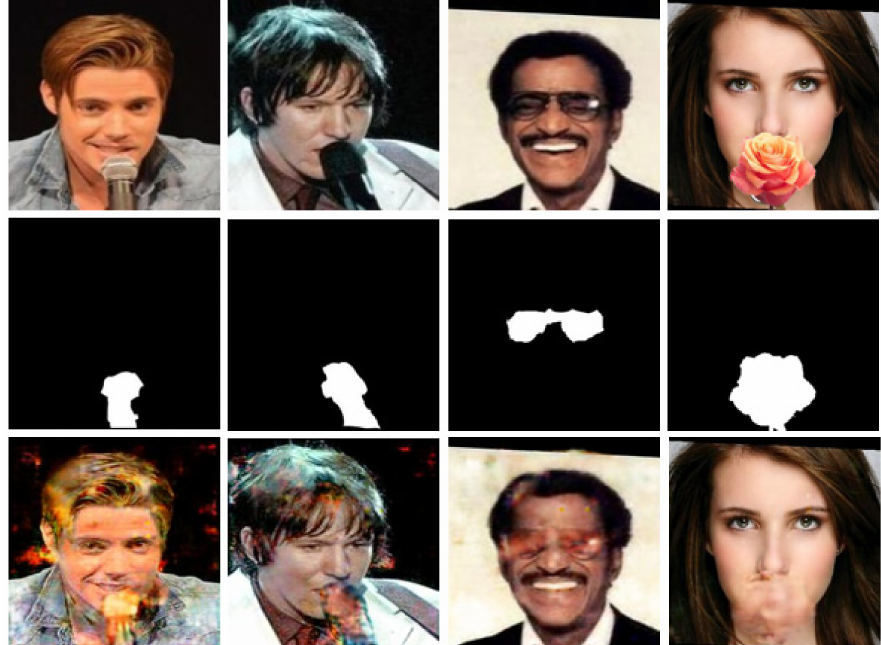
Figure 7. AFD-StackGAN performance for real face images with occlusion masks that have very different structures and locations in the face images than the occlusion masks used in the synthetic dataset. The first row shows occluded input facial images, and the second row shows de-occluded output face